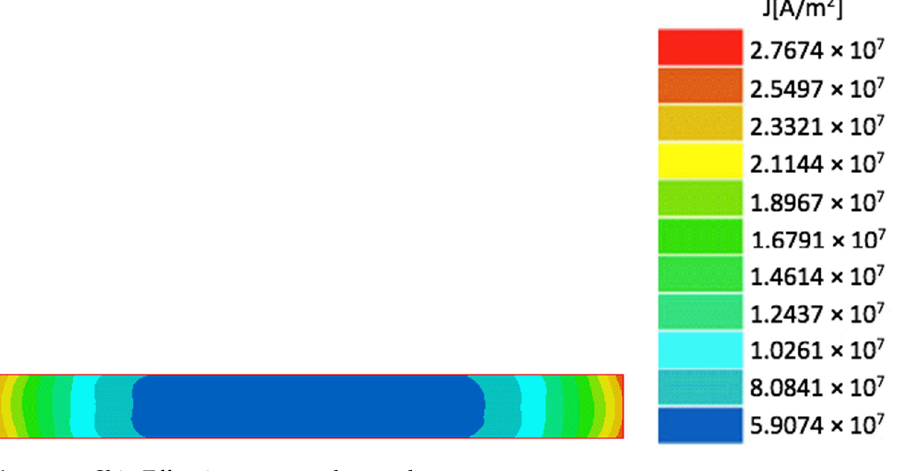
Figure 10. Skin Effect in a rectangular conductor.